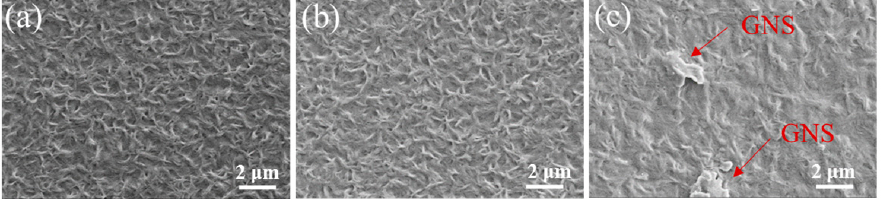
Figure 2. SEM images of surface morphologies of ( a ) neat PLLA ( b ) PSG and ( c ) PGN composites films.